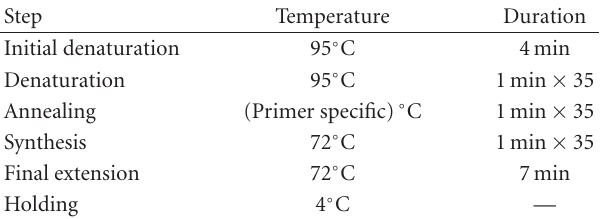
Table 3: PCR conditions for the amplification step.